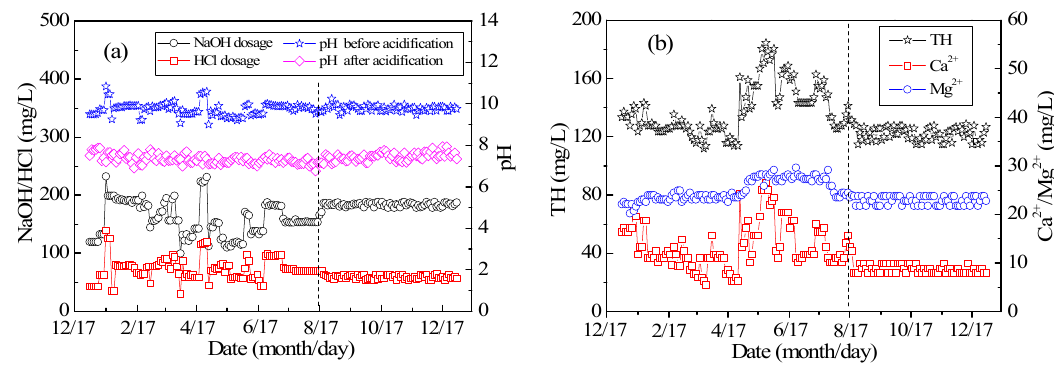
Figure 2. ( a ) Change in NaOH/HCl/pH and ( b ) TH and Ca 2+ /Mg 2+ concentrations with time.